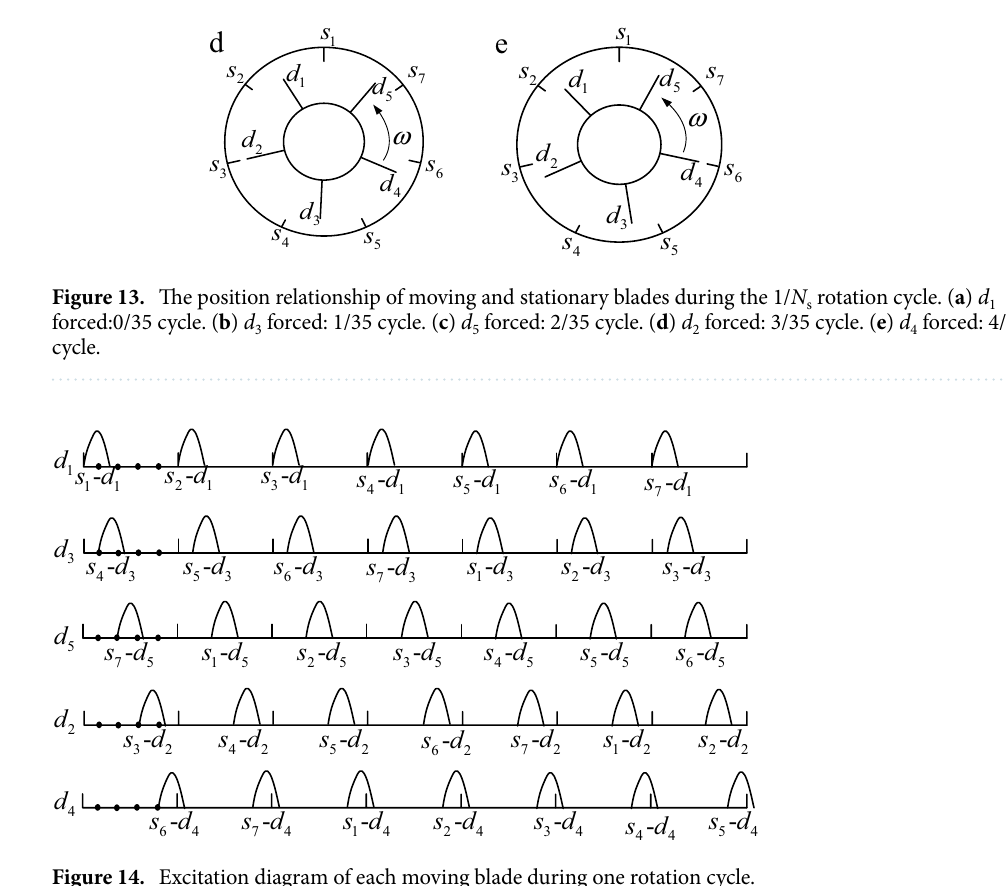
Figure 14. Excitation diagram of each moving blade during one rotation cycle.